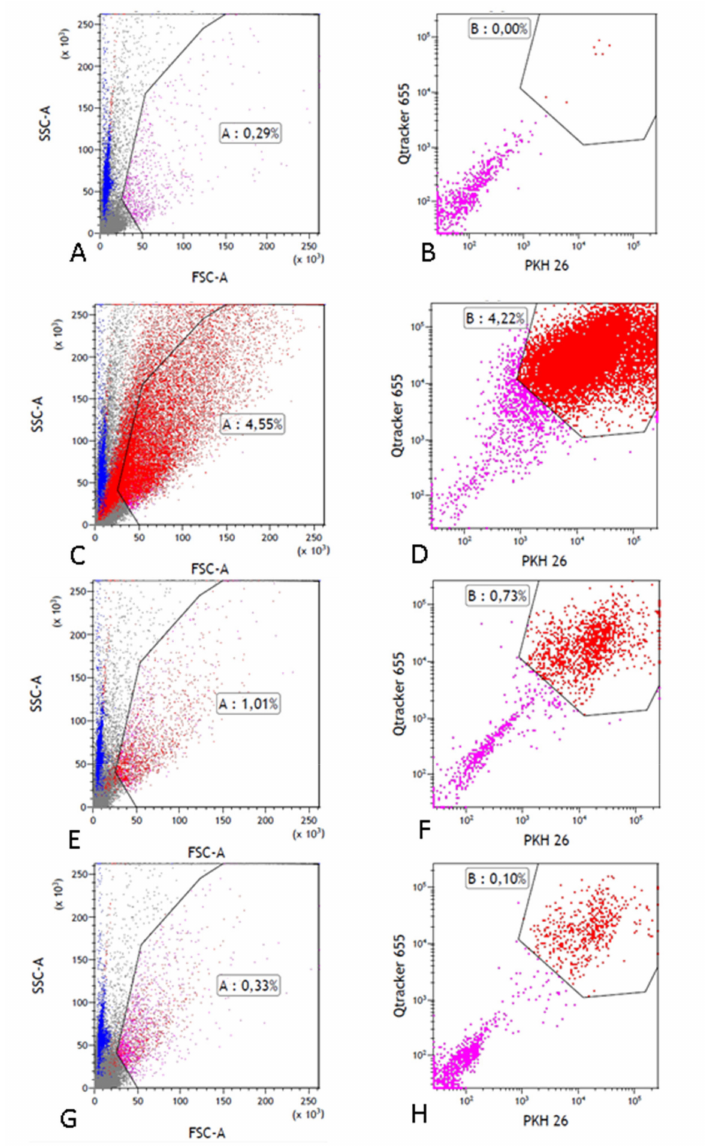
Figure A2. Example of flow cytometry results of perfusate reservoir samples. Cytograms of perfusate reservoir samples taken at di ff erent moments in time. Results shown in forward and side scatter cytograms and fluorescence signal strength cytograms of Qtracker655 and PKH26. ( A ) T = 0 sample moment, FSC-A, SSC-A cytogram, purple dots represent cells that fall within the MSC gating; 0.29% of all cells. ( B ) PKH26 and Qtracker655 cytogram of t = 0 sample, purple dots represent particles that fall in the auto fluorescence range. No dots visible in the MSC range gate. ( C ) T = 60 sample moment, FSC-A, SSC-A cytogram, purple dots represent cells that fall within the MSC gating; 4.55% of all cells. ( D ) PKH26 and Qtracker655 cytogram of t = 60 sample moment, purple dots represent particles that fall in the auto fluorescence range, red dots represent cells that fall within the MSC range gate; 4.22%. ( E ) T = 240 sample moment, FSC-A, SSC-A cytogram, purple dots represent cells that fall within the MSC gating; 1.01% of all the cells. ( F ) PKH26 and Qtracker655 cytogram of t = 240 sample moment, purple dots represent particles that fall in the auto fluorescence range, red dots represent cells that falls within the MSC range gate; 0.73%. ( G ) t = 420 sample moment, FSC-A, SSC-A cytogram, purple dots represent cells that fall within the MSC gating; 0.33% of all counted cells. ( H ) PKH26 and Qtracker655 cytogram of t = 420 sample moment, purple dots represent particles that fall in the auto fluorescence range, red dots represent cells that fall within MSC gate range;